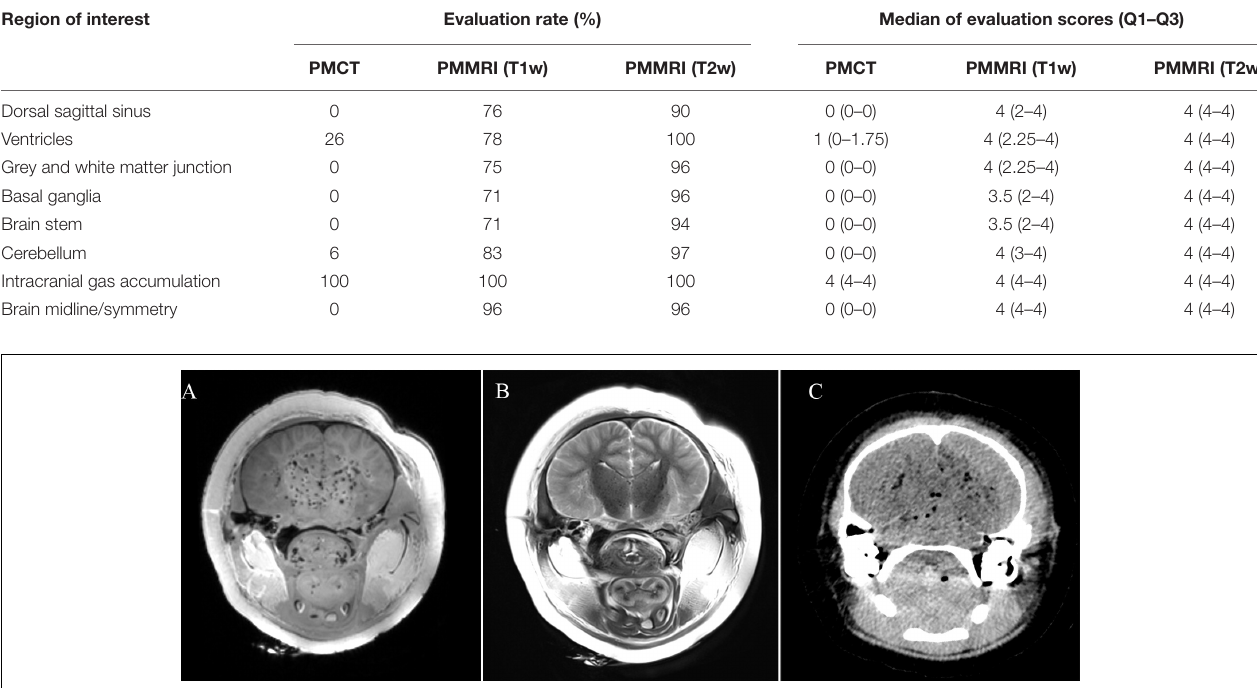
FIGURE 3 | Intracranial gas accumulation affected image quality in (A) T1w PMMRI; (B) T2w PMMRI; and (C)